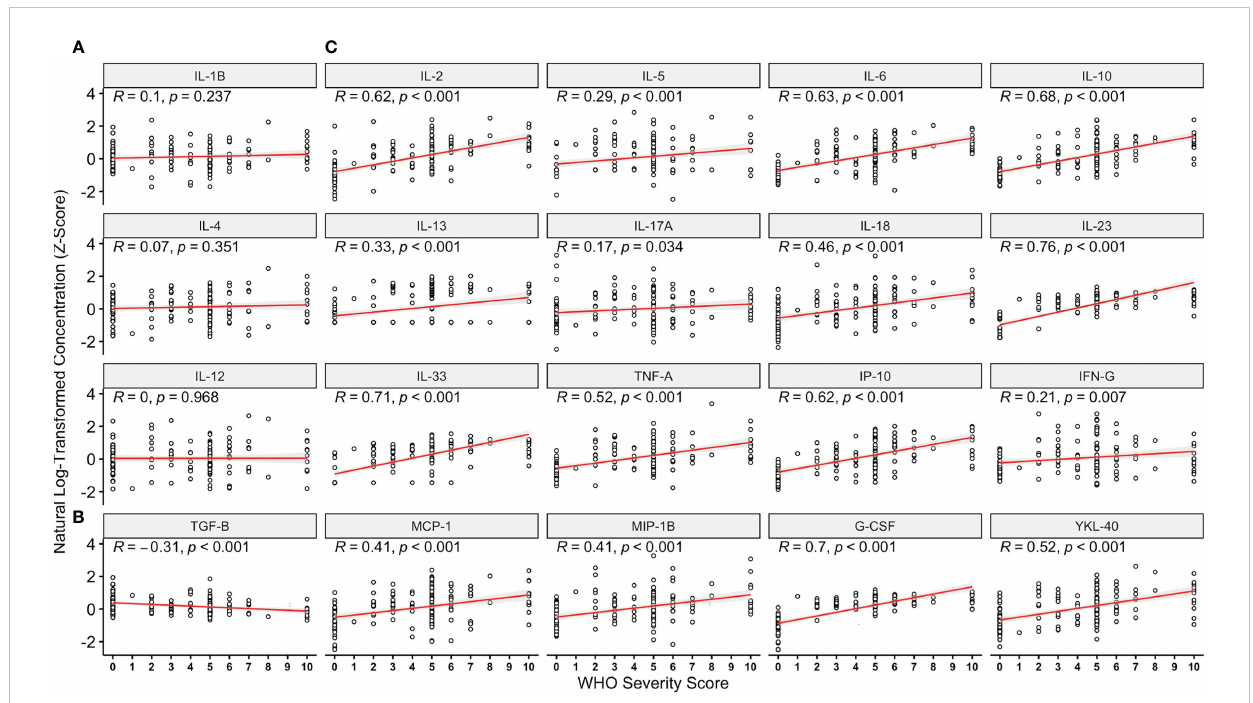
FIGURE 2 Relationships Between Analytes Studied and World Health Organisation Disease Severity Score. On analysing immune marker concentration (z- score), and maximal disease severity rated using the World Health Organisation (WHO) COVID-19 severity score, there were no associations observed for IL-1 b , IL-4 or IL-12p70 (A) whilst a negative association was seen for TGF- b (B) . All remaining 16 markers demonstrated signi fi cant correlations with WHO severity score (C) , with the strongest associations observed for IL-23, IL-33, G-CSF, IL-6, IL-2 and IL-10. Data are presented for the entire cohort including controls (n = 44, WHO score = 0) and those with acute COVID-19 illness (n = 118, WHO score =